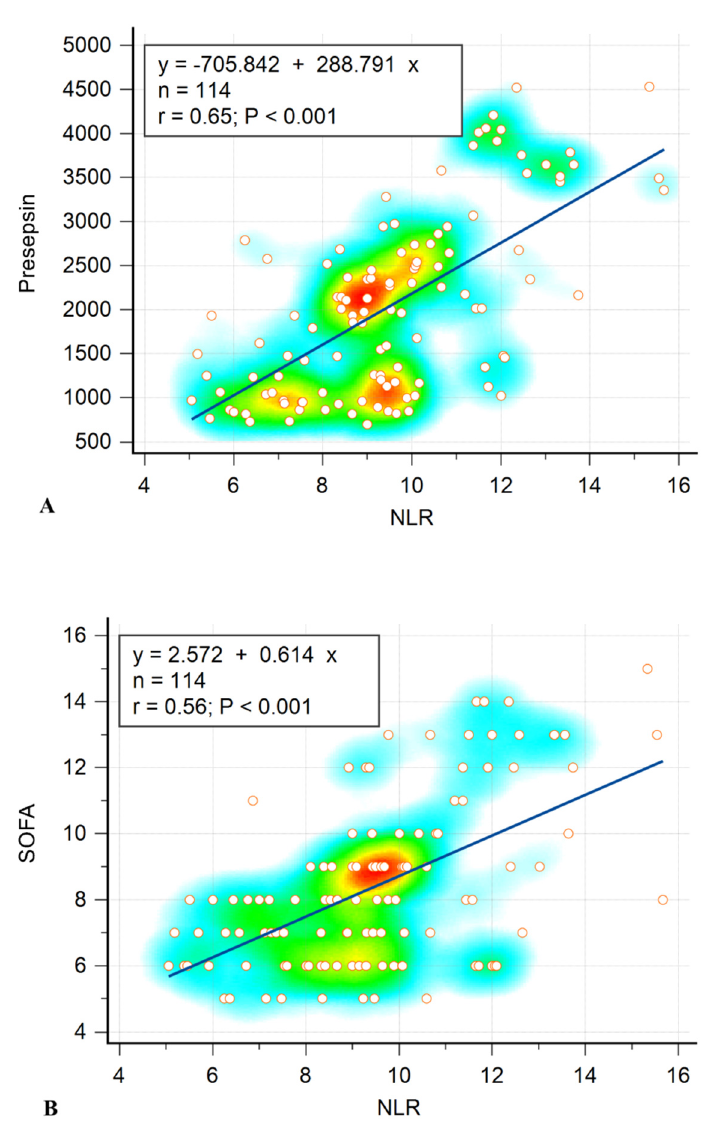
Figure 2. Correlations between NLR and Presepsin ( A ), NLR and SOFA ( B ). Data are presented as a scatter diagram with individual value markers, linear trendline, and heat-map. Correlation equation (y/x), correlation coefficient (r), and statistical significance (p) are provided within the graph. Receiver operating curve (ROC) analysis was performed to evaluate the prognosis value of NLR compared with the SOFA score and presepsin in sepsis severity assessment.